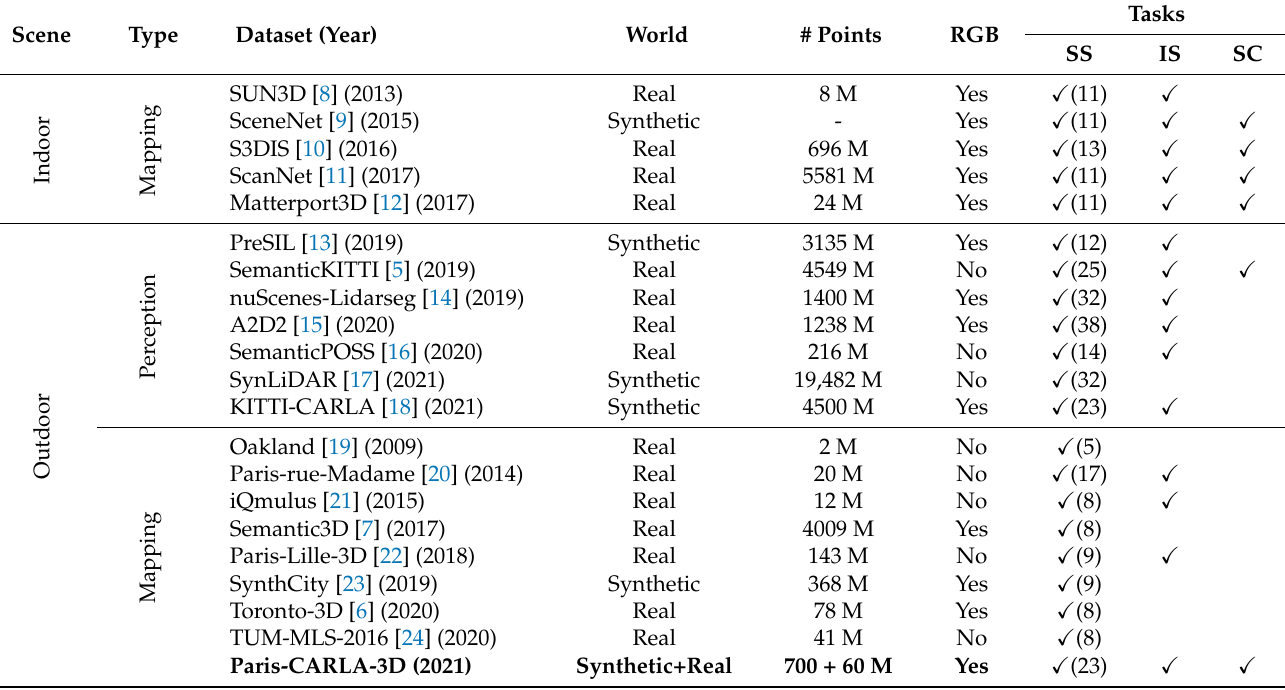
Table 1. Point cloud datasets for semantic segmentation (SS), instance segmentation (IS), and scene completion (SC) tasks. RGB means color available on all points of the point clouds. In parentheses for SS, we show only the number of classes evaluated (the annotation can have more